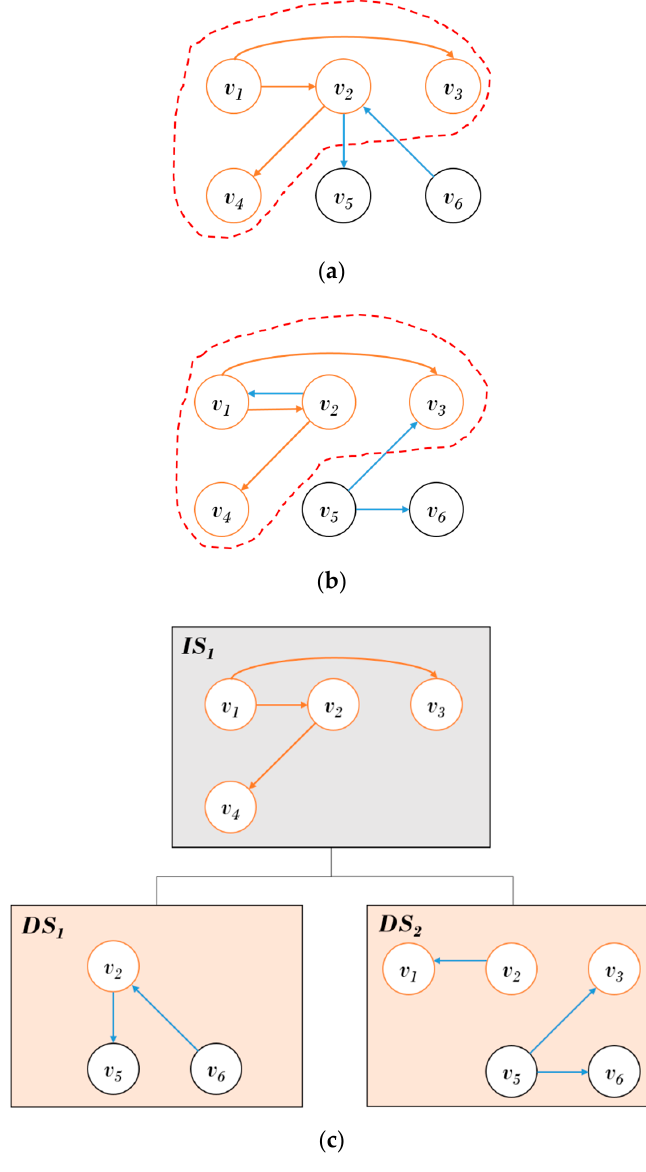
Figure 1. Proposed historical graph management structure: ( a ) Graph G 1 at time T 1 ; ( b ) Graph G 2 at time T 2 ; ( c ) Historical